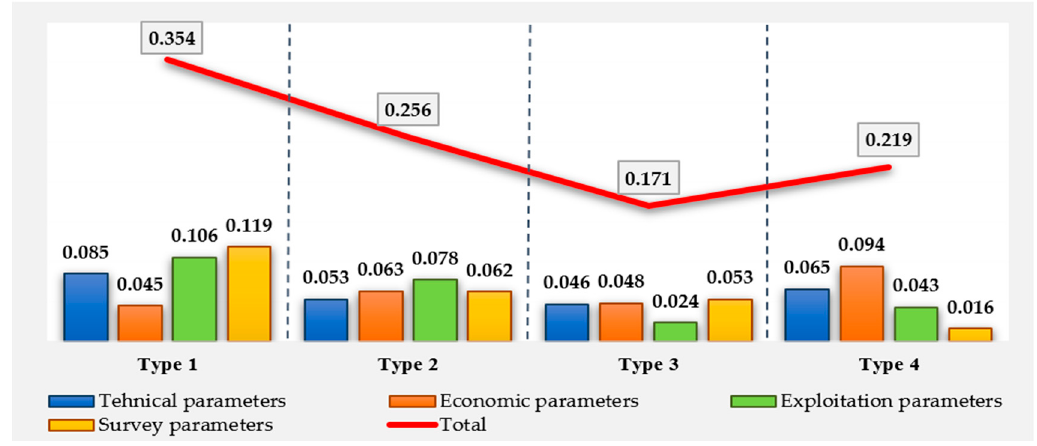
Figure 6. The structure of the model in choosing the dozer using the AHP method.